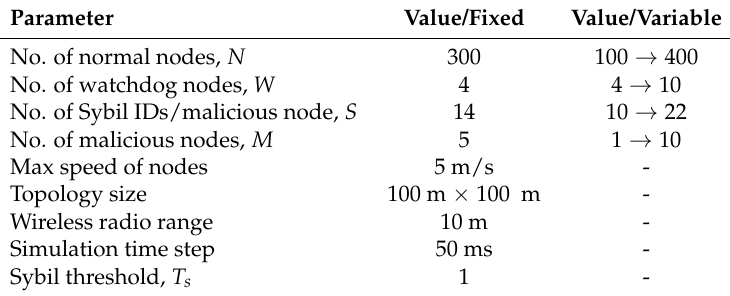
Table 1. Simulation